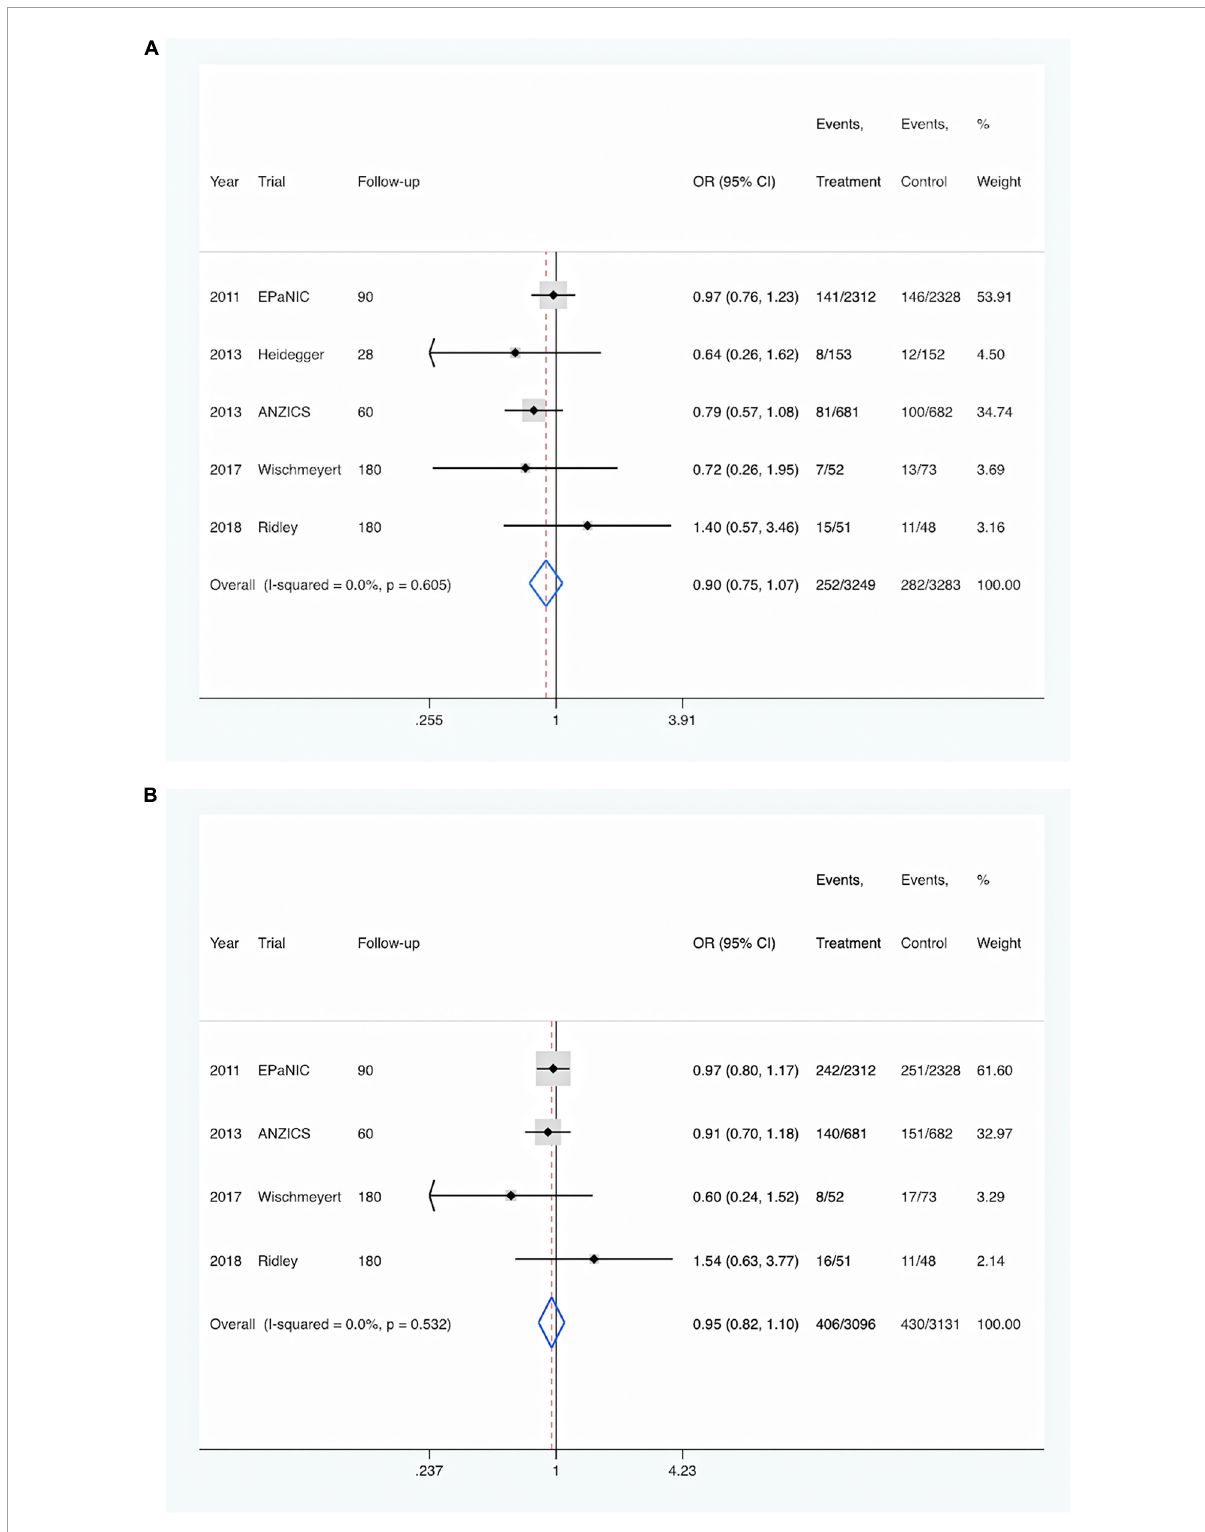
FIGURE3 Effect of SPN and EN nutrition support treatment on ICU mortality (A) and hospital mortality (B) .